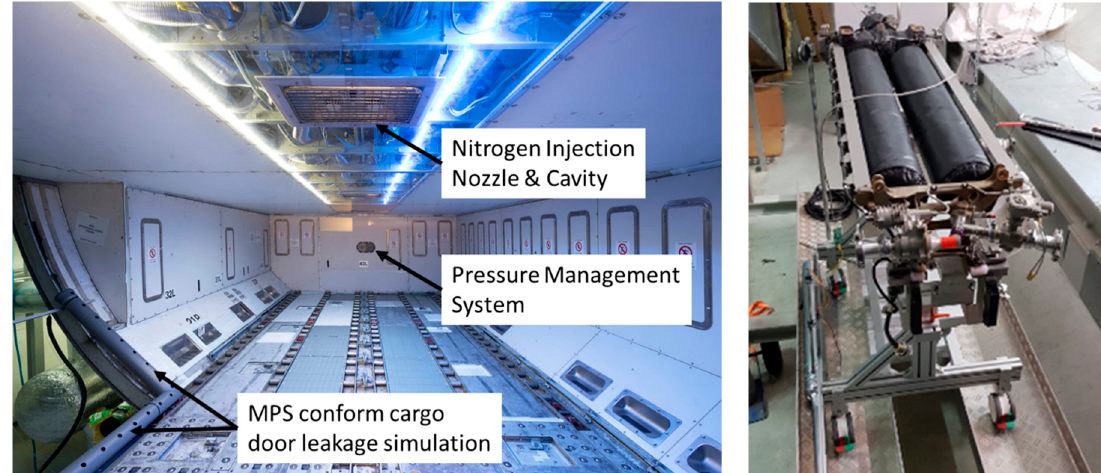
Figure 6. Refurbished cargo hold ( left ) and integrated OBIGGS ( right ).